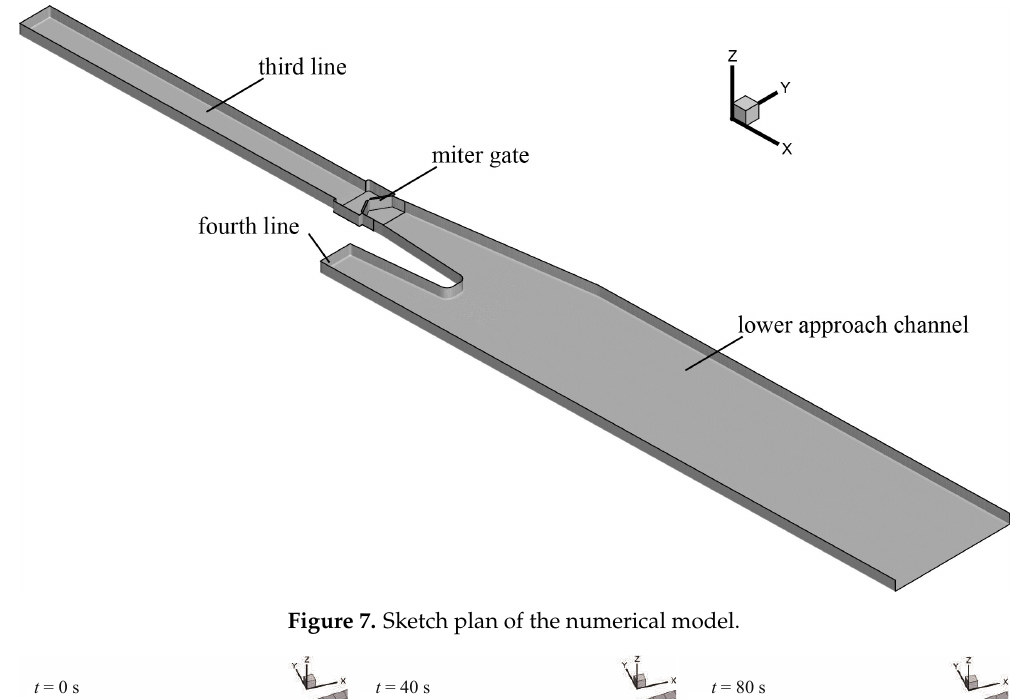
Figure 7. Sketch plan of the numerical model.